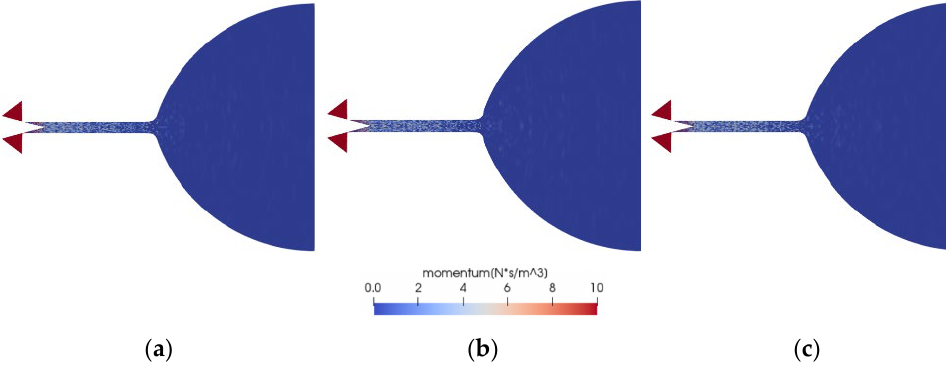
Figure 18. Molecular momentum distributions in nozzle at different gas temperatures at t = 0.1 ms.